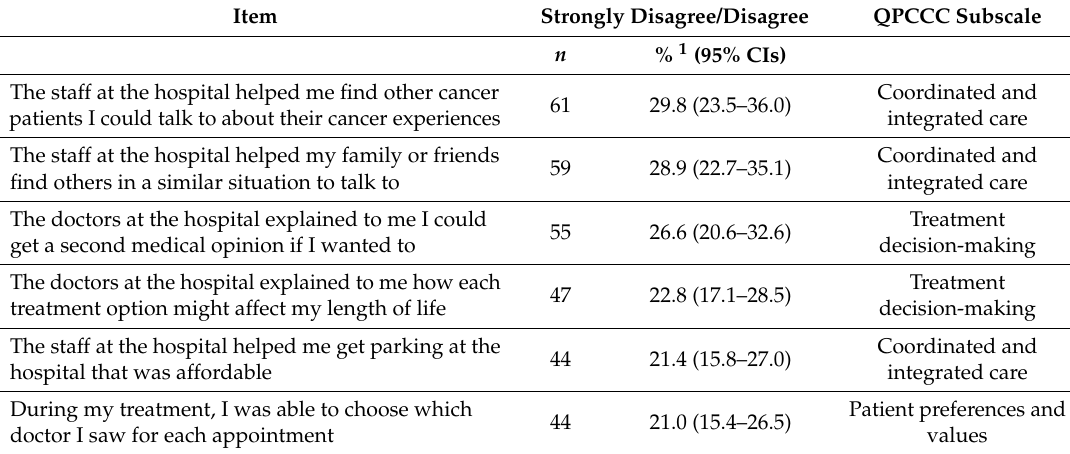
Table 4. Cancer care most commonly not delivered.